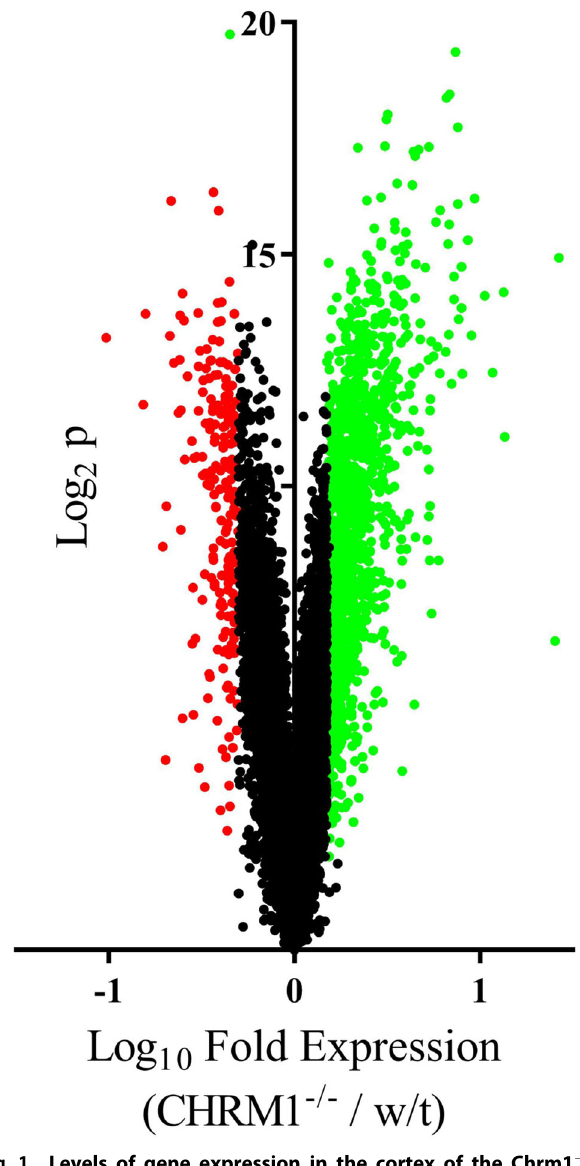
Fig. 3 Cellular functions affected by changes in cortical gene expression in the Chrm1 − / − mouse. The number of coding and noncoding RNA that are known to be associated with speci fi c cellular functions that had either higher (green columns) or lower (red columns) levels on the cortex of Chrm1 − / −